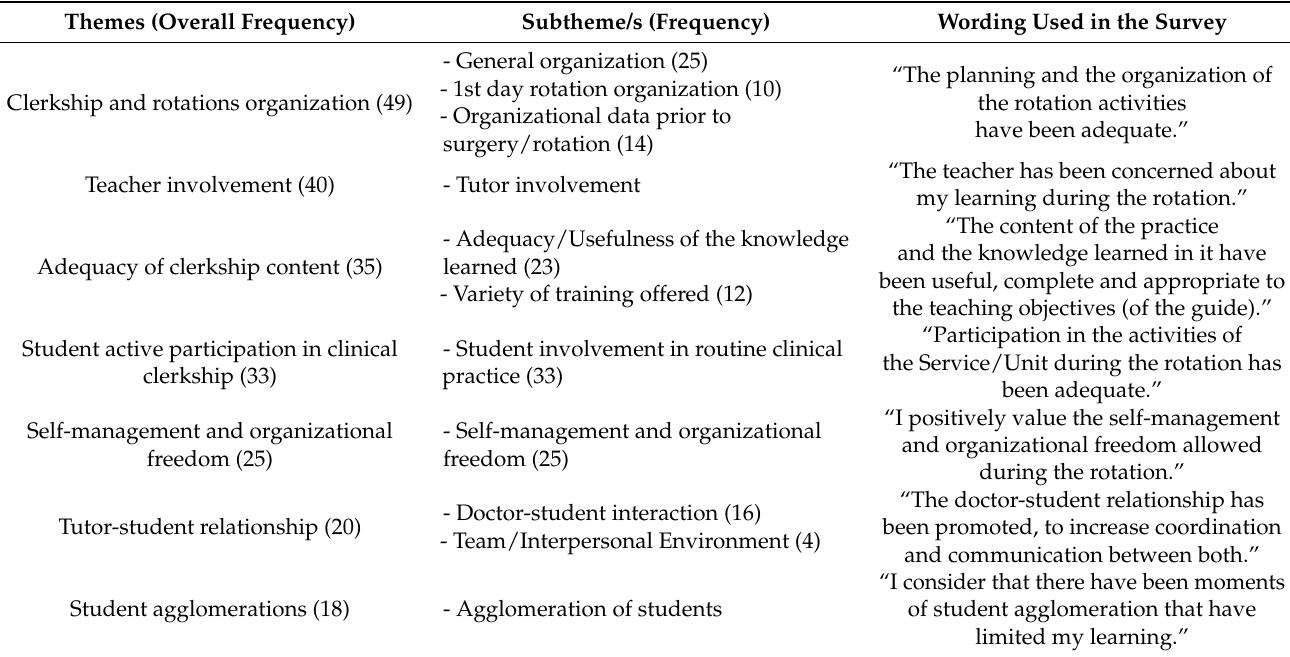
Table 1. Themes (and overall frequency), subtheme/s (and frequency), and proposed wording for the items in the survey extracted from the semi-structured telephone